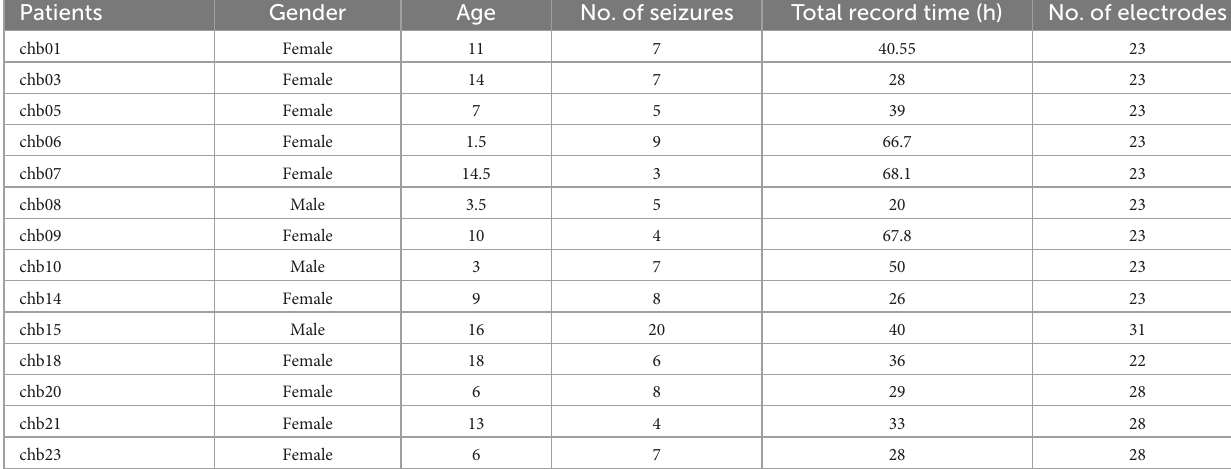
TABLE 1 Summary of the 14 patients in the CHB-MIT dataset.